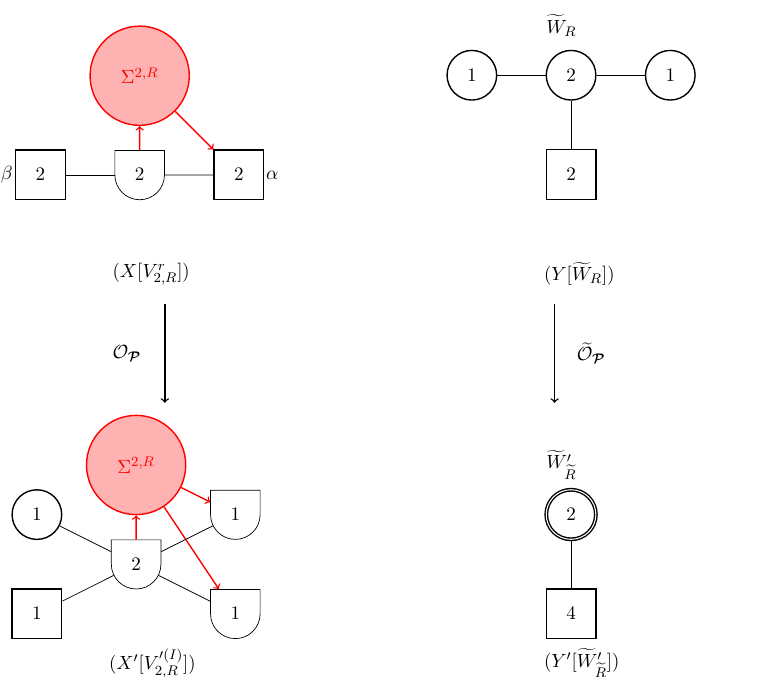
Figure 30 . The construction of a vortex defect in a flavored D 4 quiver gauge theory and its dual Wilson defect, using an Abelian gauging